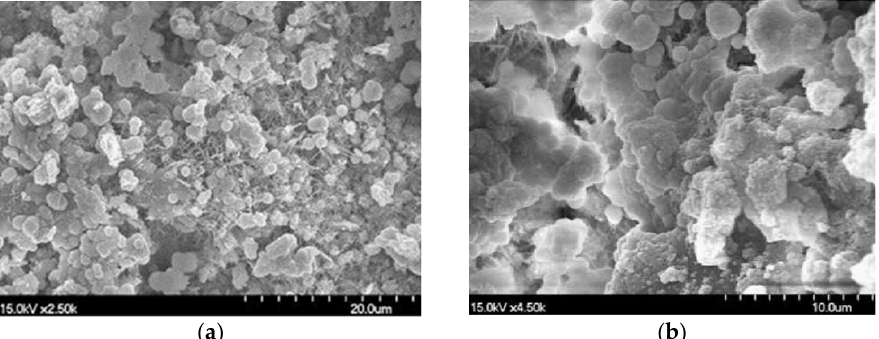
Figure 16. Surface microstructure of the concrete with slag at the curing age of: ( a ) 1 d; ( b ) 28 d [44]. Reproduced with permission from [44], Elsevier, 2010.